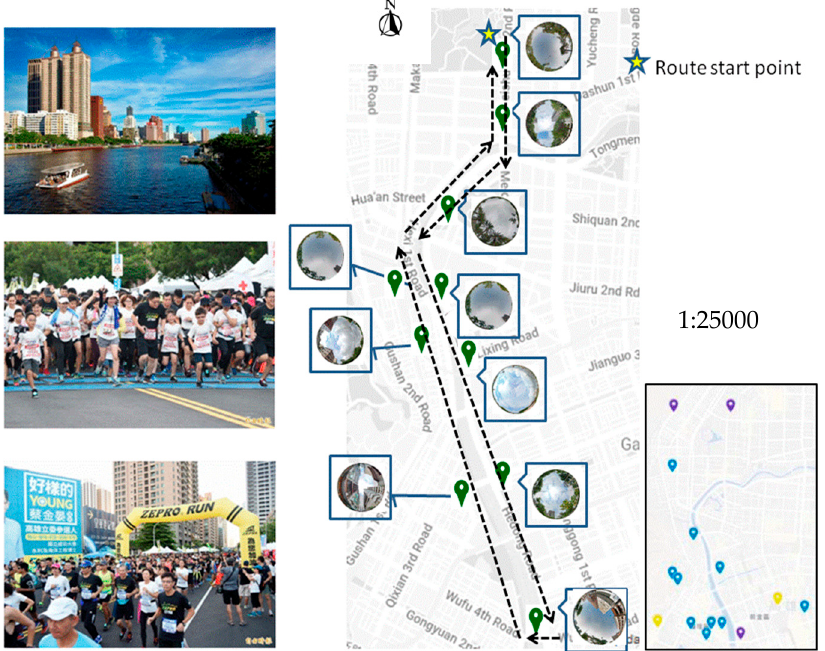
Figure 6. Summer running event route, activity photos, and fisheye photos.